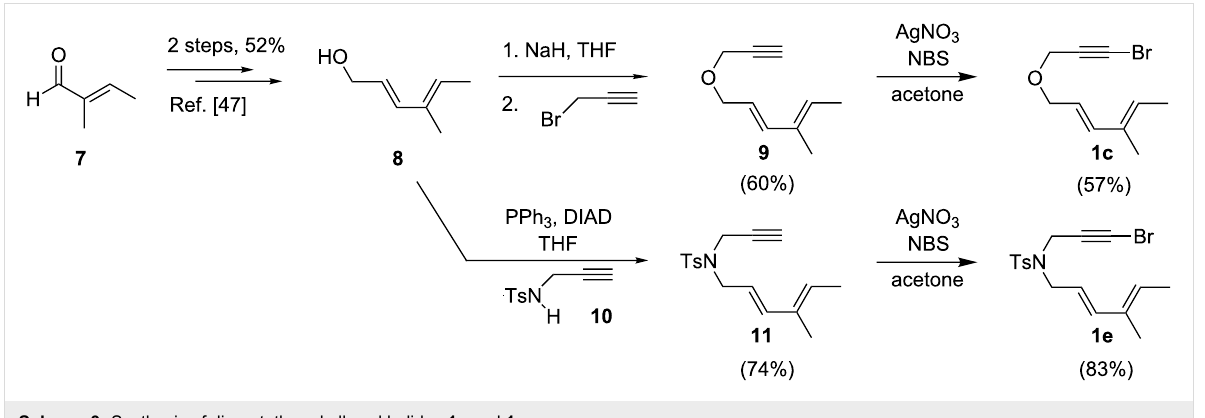
Scheme 3: Synthesis of diene-tethered alkynyl halides 1c and 1e .